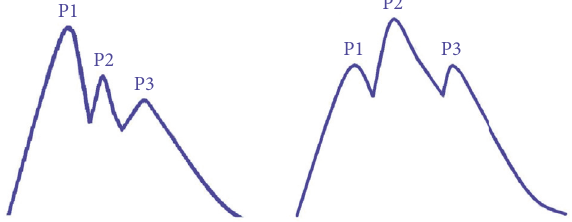
Figure 1: Intracranial pressure (ICP) waveforms. Percussion wave (P1) represents arterial pulsation, tidal wave (P2) represents brain tissue compliance, and dicrotic wave (P3) is due to closure of aortic valve. Under normal conditions, P1 > P2, indicative of normal compliantbrain.InABIbraincompliancestartsdecreasingresulting in reversal of P1: P2 ratio (i.e., P2 > P1) which is a sensitive predictor of poor brain